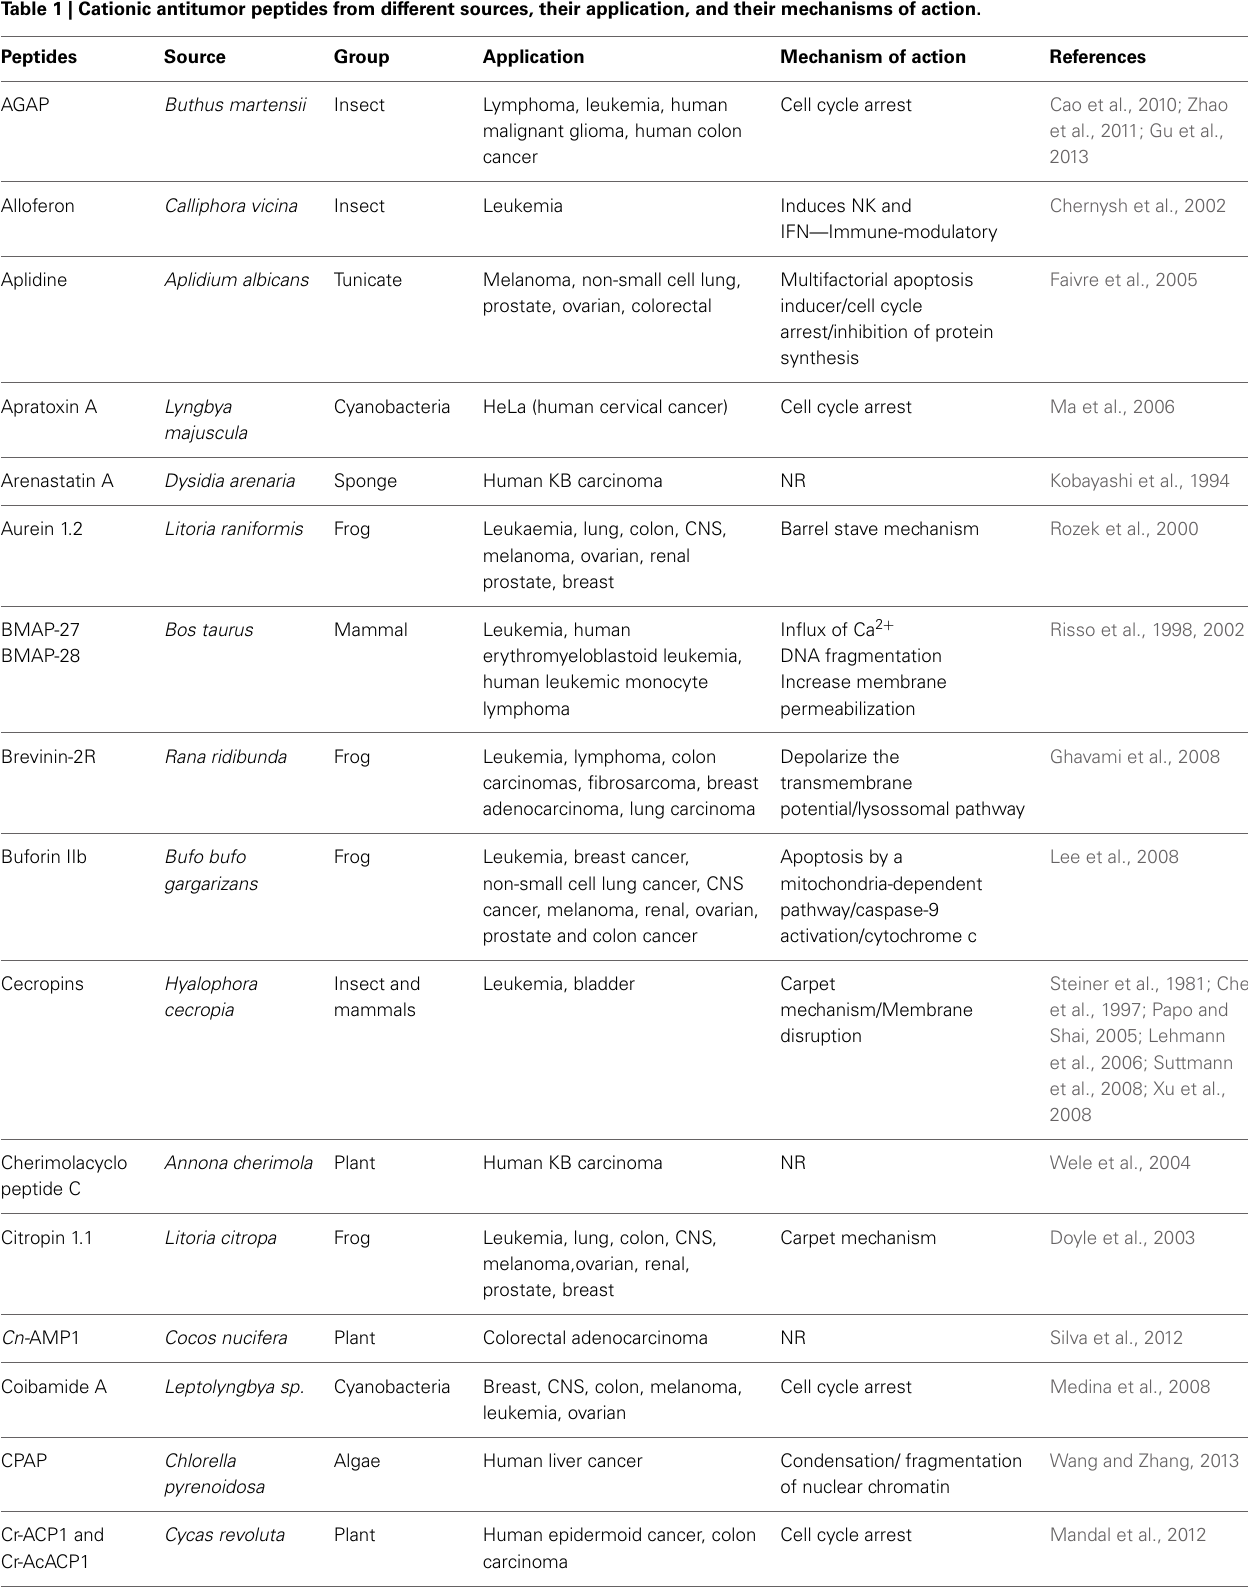
Table 1 | Cationic antitumor peptides from different sources, their application, and their mechanisms of action.